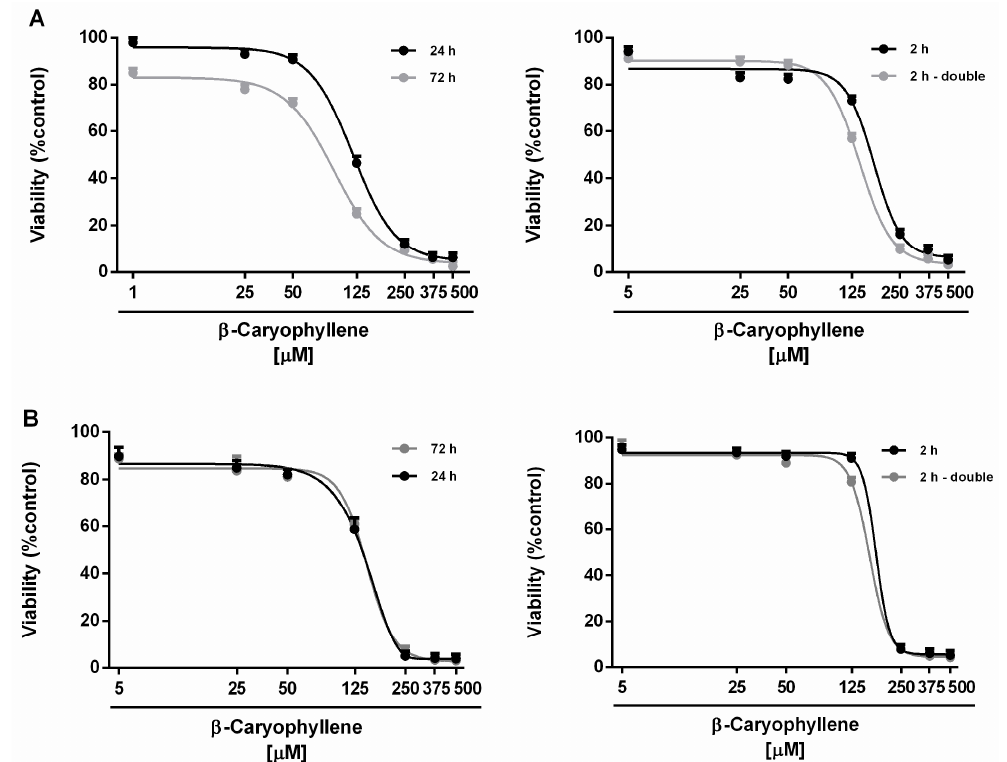
Figure 2. Cytotoxicity of β -caryophyllene in Mz-ChA-1 cholangiocarcinoma cells ( A ) and H69 cholangiocytes ( B ) under both the single long-term exposures of 24 h and 72 h and the metronomic schedule. In the last protocol, the cells were subjected to a single and / or double repeated short exposure of 2 h followed by a recovery time of 72 h. Data are expressed as mean ± SE (standard error) of at least two experiments in which each treatment was tested at least in triplicate ( n = 6).